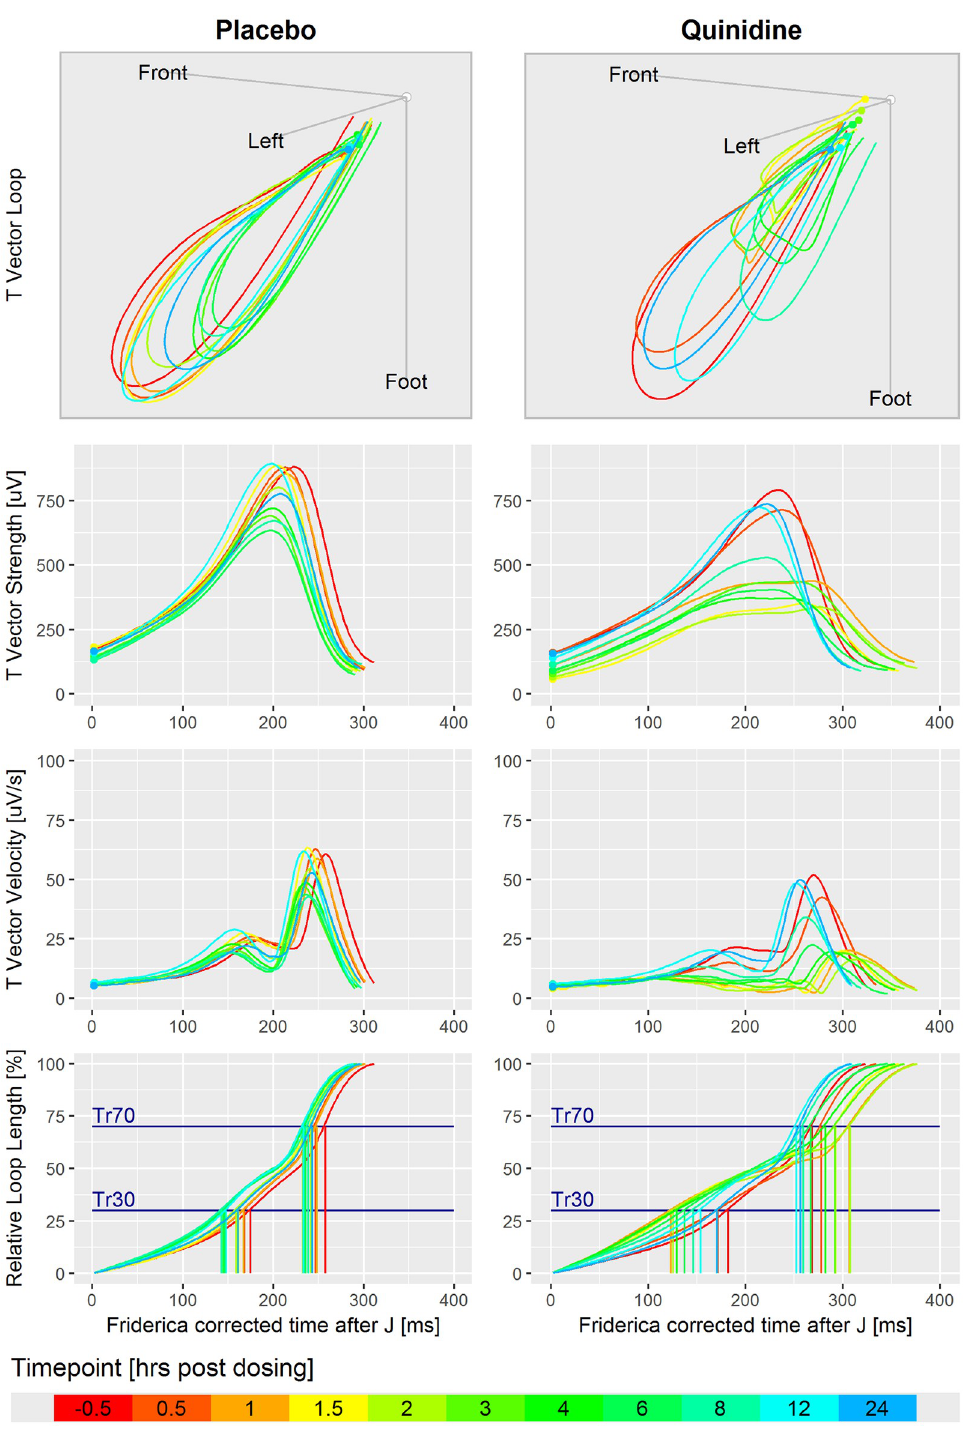
Fig 2. Illustration of the derivation of the TVV and the T vector trajectory quantiles. Displayed are ECGs of subject 1017 in Study A under placebo (left column) and under quinidine treatment (right column). Colors indicate the relative time with respect to dosing. 1 st row: T vector loops in the 3-dimensional space. Each loop is the average loop of the normal sinus heartbeats in the first replicate at the given time point. The coordinate system is located in the center of the heart with the axes pointing to the body’s front, left side and to the foot. 2 nd row: Time courses of the T vector strength. 3 rd row: Time courses of the TVV. 4 th row: Cumulated and normalized TVV over time, that is the relative loop length reached at a given time, with 30% and 70% trajectory